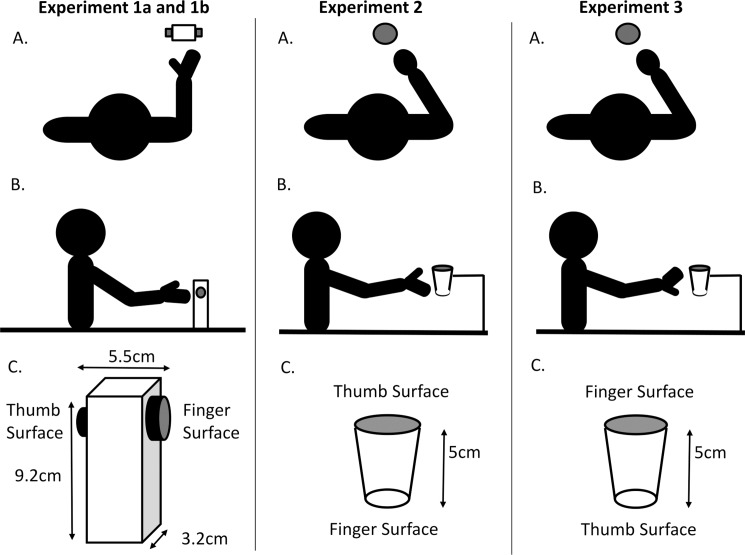
Experimental layout and target objects.Bird’s eye view (top), side view (middle) and schematic of the target objects (bottom) for Experiment 1a and 1b (left) Experiment 2 (middle) and Experiment 3 (right). In experiments 1a and 1b the object was grasped with the finger and thumb on either side. In experiment 2 the object was grasped with the thumb on top and finger underneath whist the opposite was the case for Experiment 3. In all cases the starting position was defined by a small (pea-sized) moulded grip on the table top along a sagittal plane (where the plane included the acromion process of the shoulder and the long axis of the object). In Experiment 1a, the target object was placed at one of three horizontal distances from the start point (10cm, 30cm or 50cm). In Experiment 1b it was placed 30cm from the start point. In Experiments 2 and 3 it was placed at one of three horizontal distances from the start point (10cm, 30cm or 50cm) but this time was 15cm above the table top.